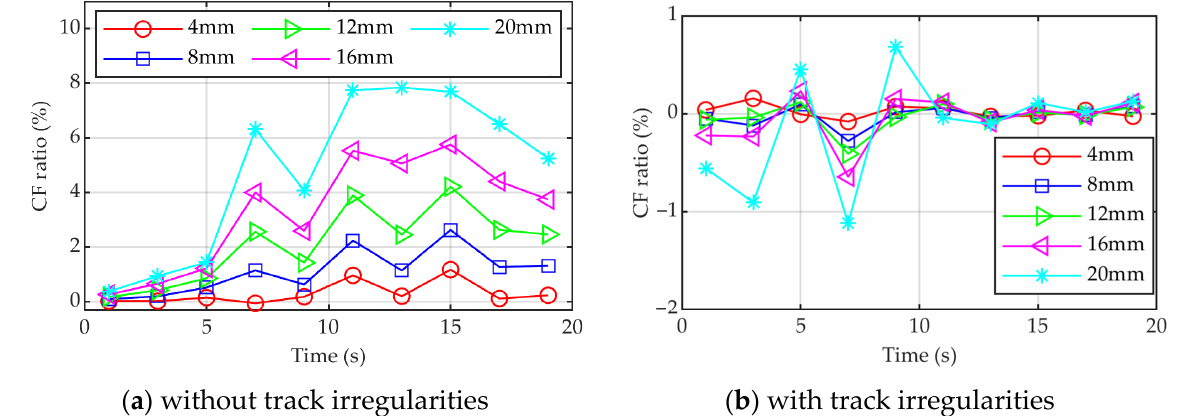
Figure 11. Feature evolution of longitudinal vibration of the first gearbox housing under traction condition.